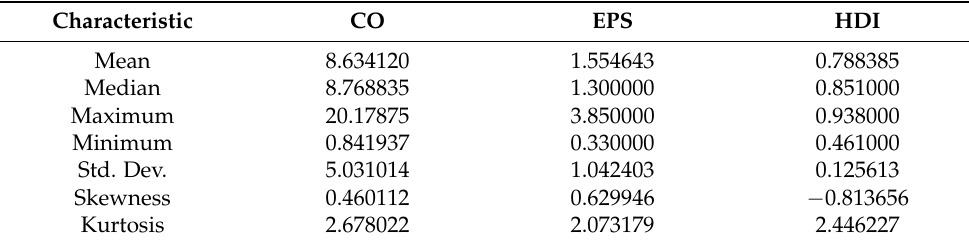
Table 2. Summary statistics of the dataset.